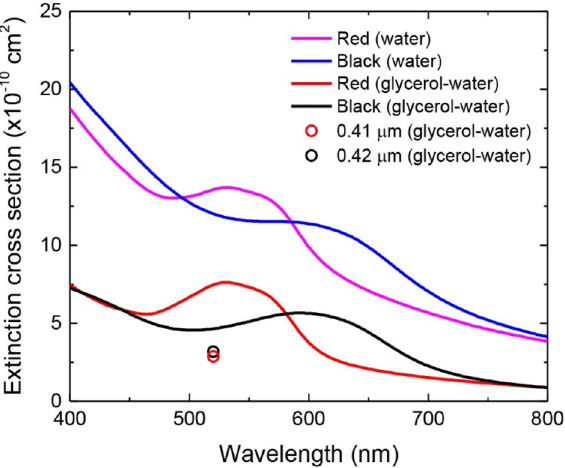
Figure 5. Extinction spectra of CLBs in solution. The spectra are measured for red and black latex beads suspended in water and 90% glycerol/water. Concentrations of both beads in the solutions are 0.004%. Red and black open circles are calculated scattering cross sections at 520 nm, predicted by Mie calculations for undyed polystyrene microspheres (diameters of 0.41 μm and 0.42 μm) in 90%